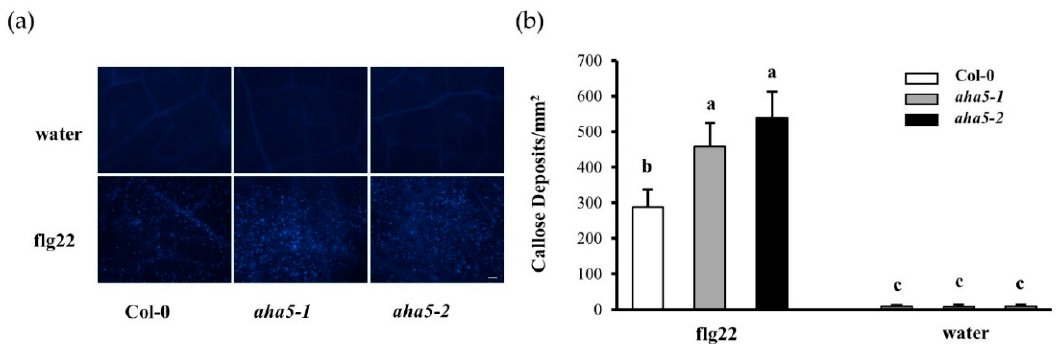
Figure 4. The aha5 mutant plants increased the callose deposition upon the PAMP flg22 treatment. ( a ) The images of callose deposition upon the PAMP flg22 induction under the microscopy. Four-week-old plants were infiltrated with 50 µM flg22 or water. The leaves were harvested for aniline blue dye staining 16 h after the infiltration. ( b ) Quantification of callose deposition was determined with ImageJ software. The data represent means ± SE (n = 15) from one of the three independent repeats with consistent results. Different letters a–c within the figure ( b ) indicate significant differences at p < 0.05, which were calculated by a one-way analysis of variance (ANOVA) using SPSS ver. 21. (IBM SPSS Statistics, New York, NY, USA).